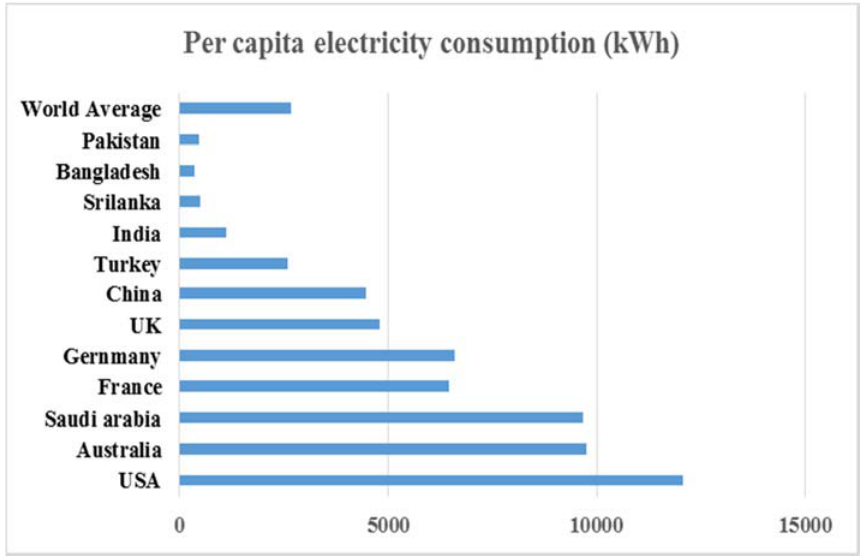
Figure 5. Evaluation of per capita EC for selected nations (Source: BP Statistical review).